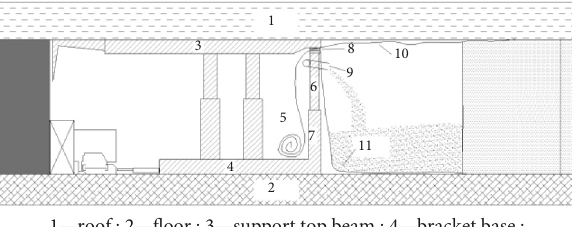
Figure 7: Whole backfill space sealing in mining